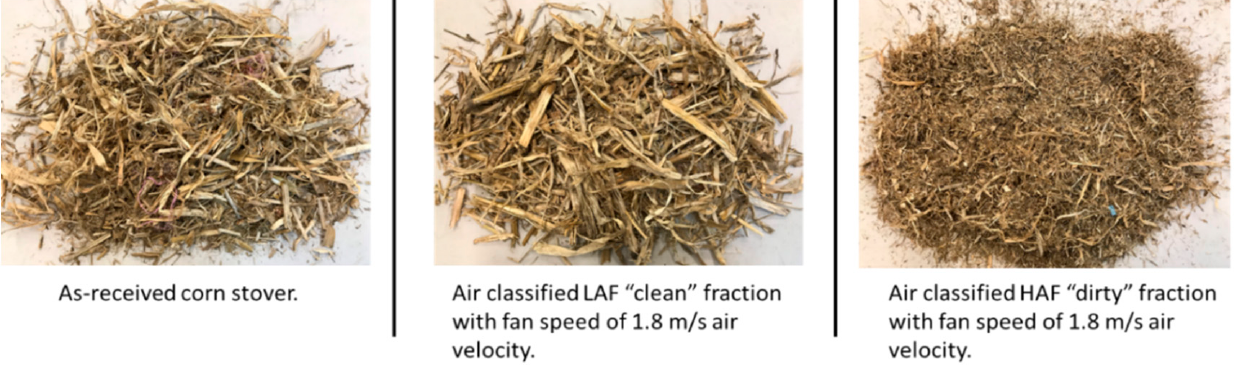
Figure 1. Photo of the original (ORG) prepared corn stover (CS) and the air classified separated CS with high ash fraction (HAF) and light ash fraction (LAF)